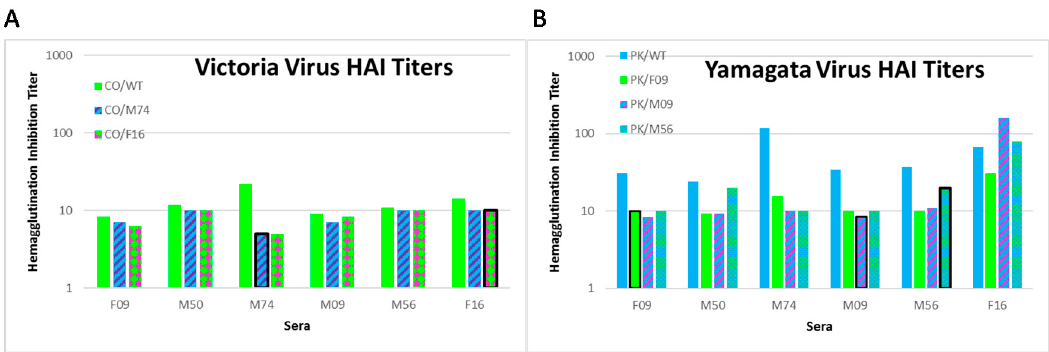
Figure 2. Hemagglutinin inhibition titer for select escape viruses. HAI titers for Victoria lineage viruses ( A ) and Yamagata lineage viruses ( B ) are shown. Viruses are labeled in the legend as for Tables 1 and 2. The data for the CO / WT and PK / WT viruses (from Tables 1 and 2) are shown as the green and blue bars in panels A and B, respectively. Graph bars are colored to indicate the predominance of B / CO-like (green) or B / PK-like (blue) amino acids at positions highlighted in Figure 1. Red stripes indicate changes to the 120- and 150-loops; and red dots indicate the G141R change. Graph bars with a black outline indicate that the virus was generated using the sera indicated in that column.